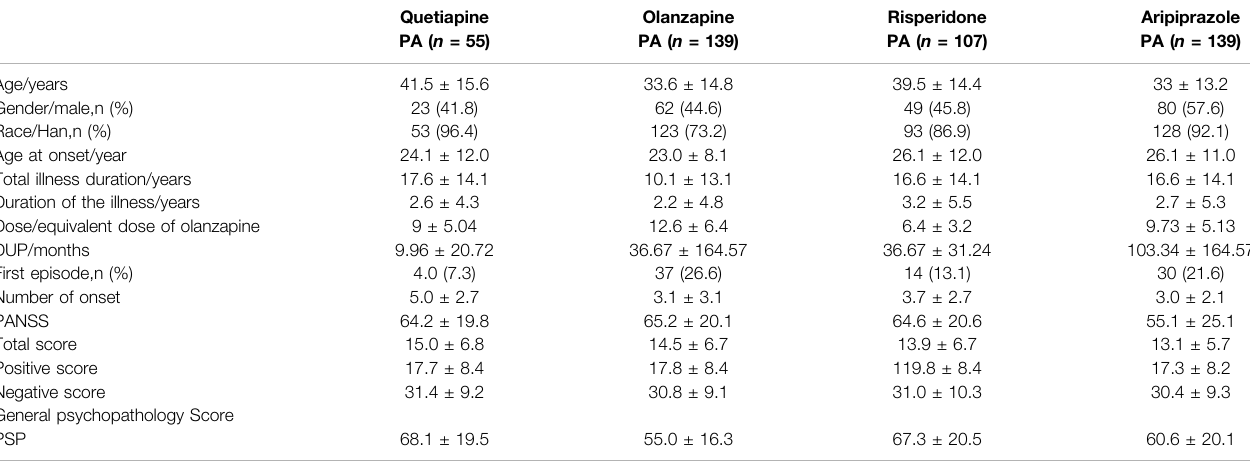
TABLE 2 | Demographic and clinical characteristics of the study population (PA).